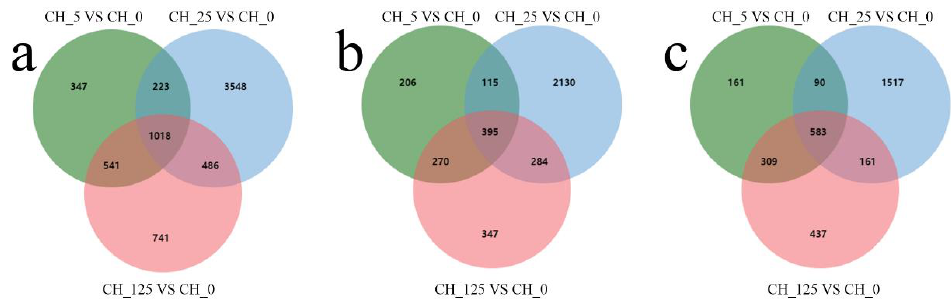
Figure 5. Differentially expressed genes (DEGs) of male catkin treated with three different concen- trations of N-(2-chloro-4-pyridyl)-N’-phenylurea (CPPU) (5 mg·L −1 , 25 mg·L −1 , and 125 mg·L −1 ). ( a – c ) Differential gene expression maps drawn using the fragments per kilobase of exon per million reads mapped (FPKM) method. The red and green dots represent DEGs with |Fold change| > 2 and FDR < 0.05. ( d ) The number of DEGs. The red and green columns indicate up- and down-regulated DEGs, respectively.